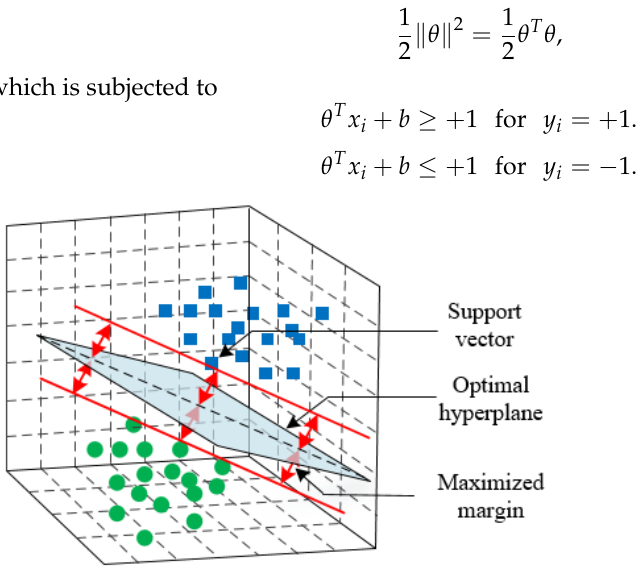
Figure 2. Illustration of SVM classifier.